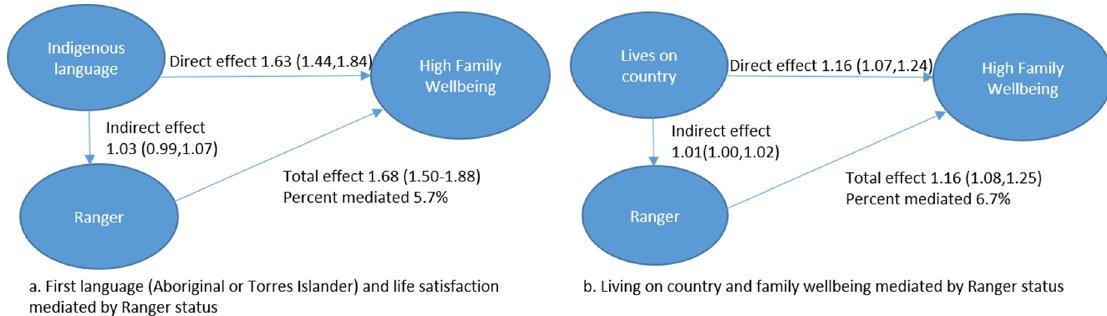
Figure 2. Directed Acyclic Graph showing relationships between cultural factors (( a ). first language, ( b ). living on country) and very high life satisfaction mediated by Ranger status.